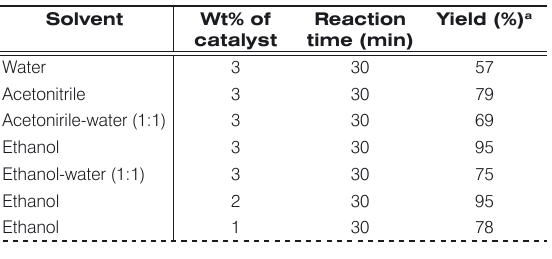
Table 1. Optimization of reaction conditions and wt% of scolecite catalyst for the synthesis of 2-(4-chlorophenyl)-4,5-